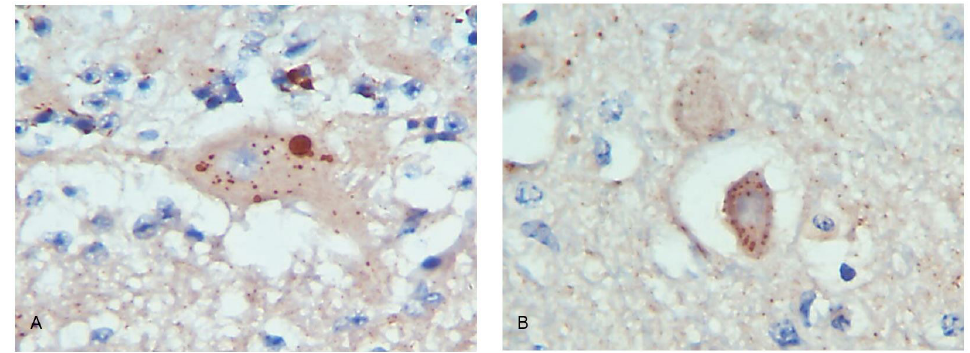
Figure 3. Negri bodies (brown immunostaining) in bovine cerebellum (A) and in equine brainstem (B) – IHC 400X.